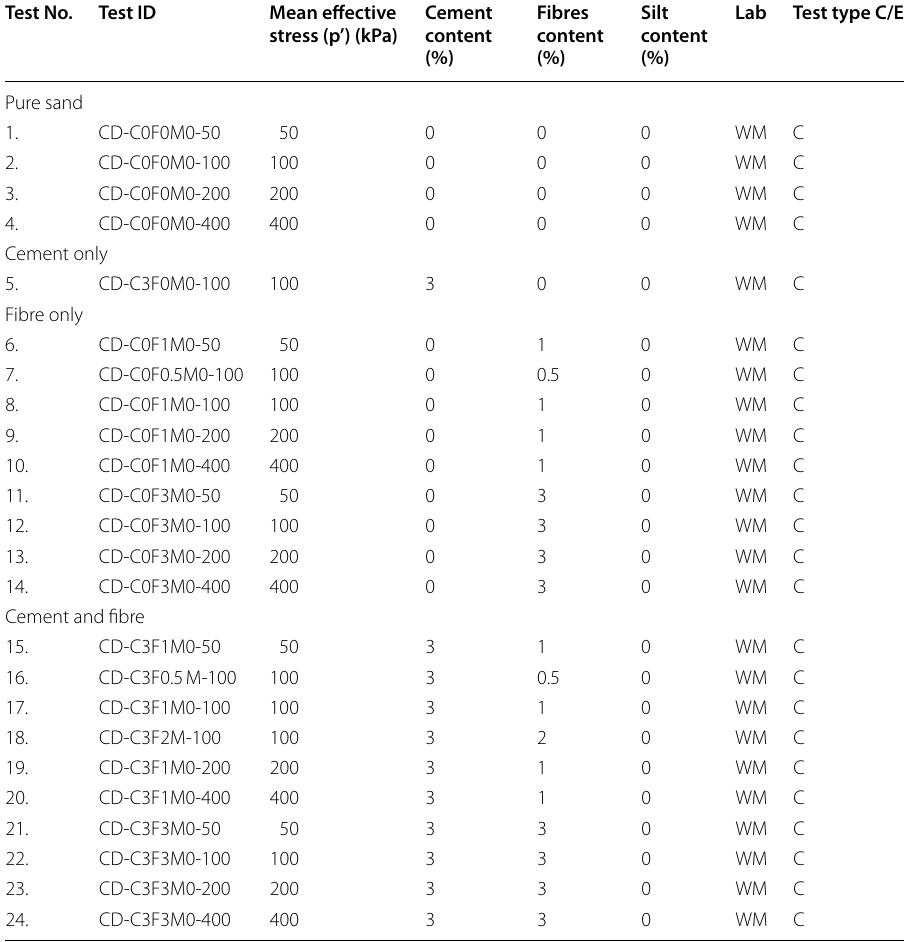
Table. 1 Testing program for consolidated drained (CID) compression tests (Current